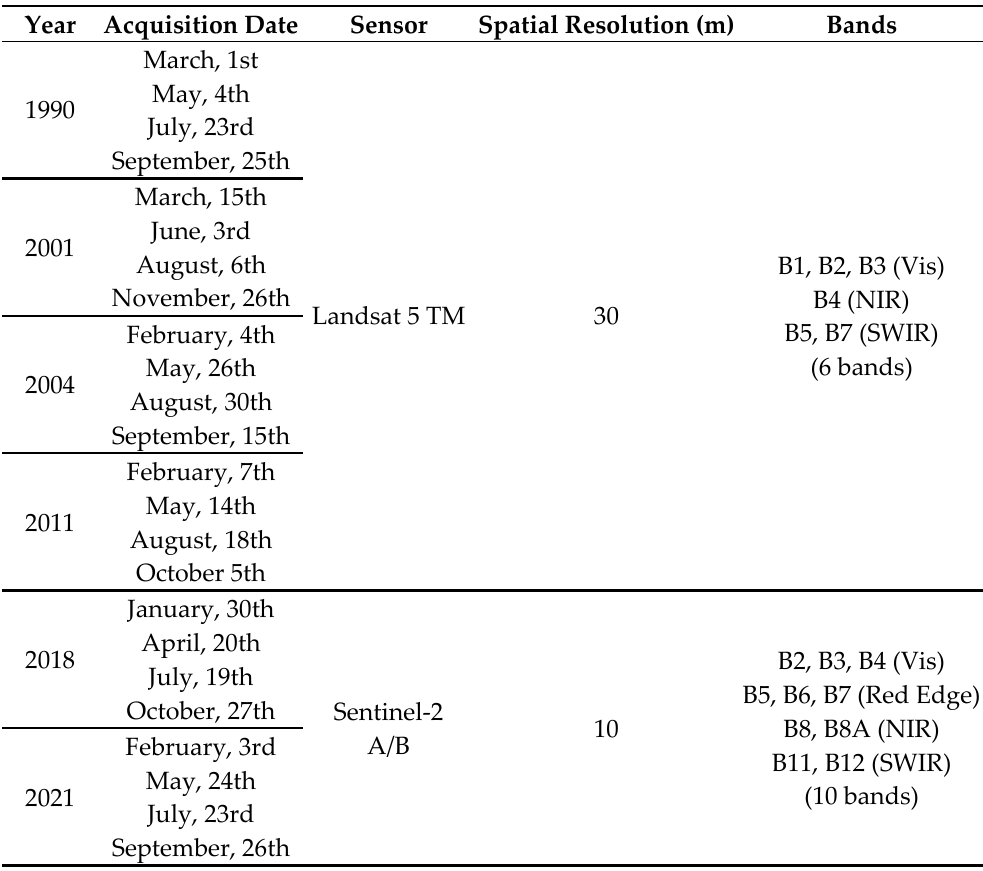
Table 1. List of satellite imagery